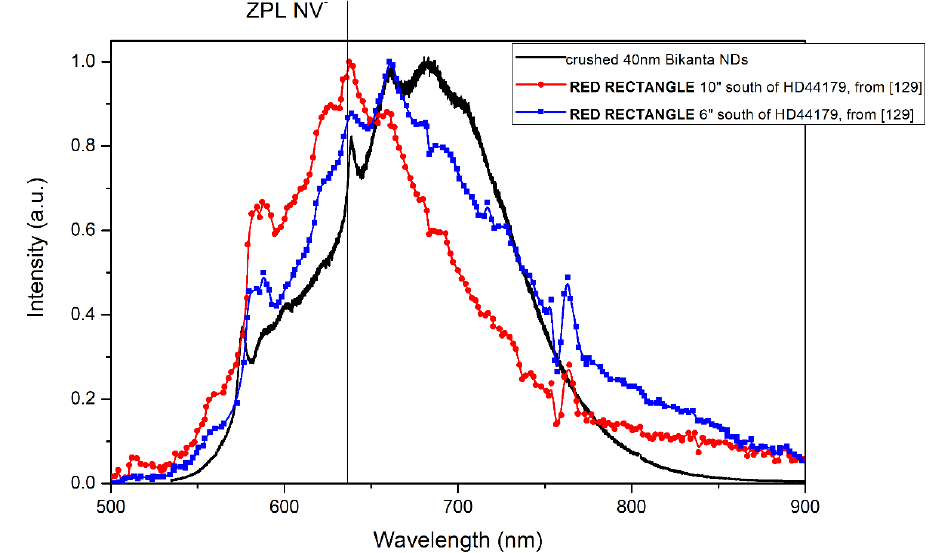
Figure 20. Comparison between a typical photoluminescence spectrum of 40 nm crushed NDs obtained under 532 nm optical pumping and the extended red emission (ERE) emission from the red rectangle. The peak at 637 / 638 nm is strongly reproducible and was first observed in [128]. Its compatibility with the zero phonon line of the NV − center in NDs is evidenced with a vertical line. A better, longer wavelength, PL-tail compatibility is expected under far-UV irradiation, as from Reference [132]. The peak at around 580 nm could be correlated with the NV 0 zero phonon line. Data of ERE (blue and red curve) are reproduced from [129].